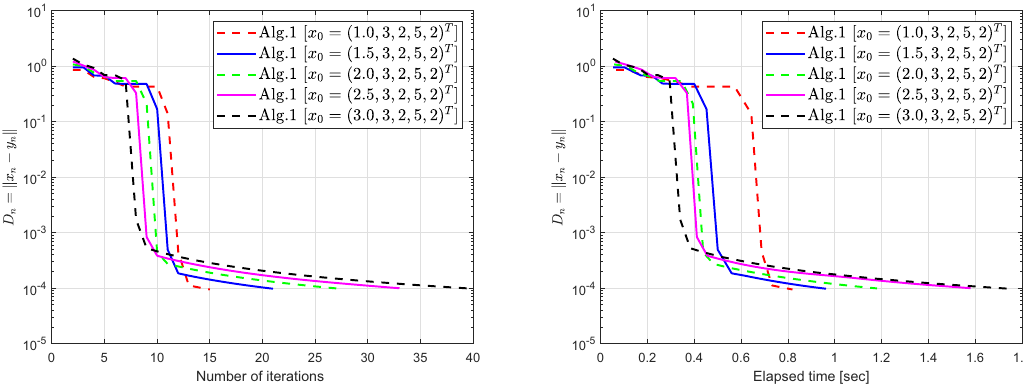
Figure 2: Example 6.1: Choosing di ff erent initial points and behavior for Algorithm 1.